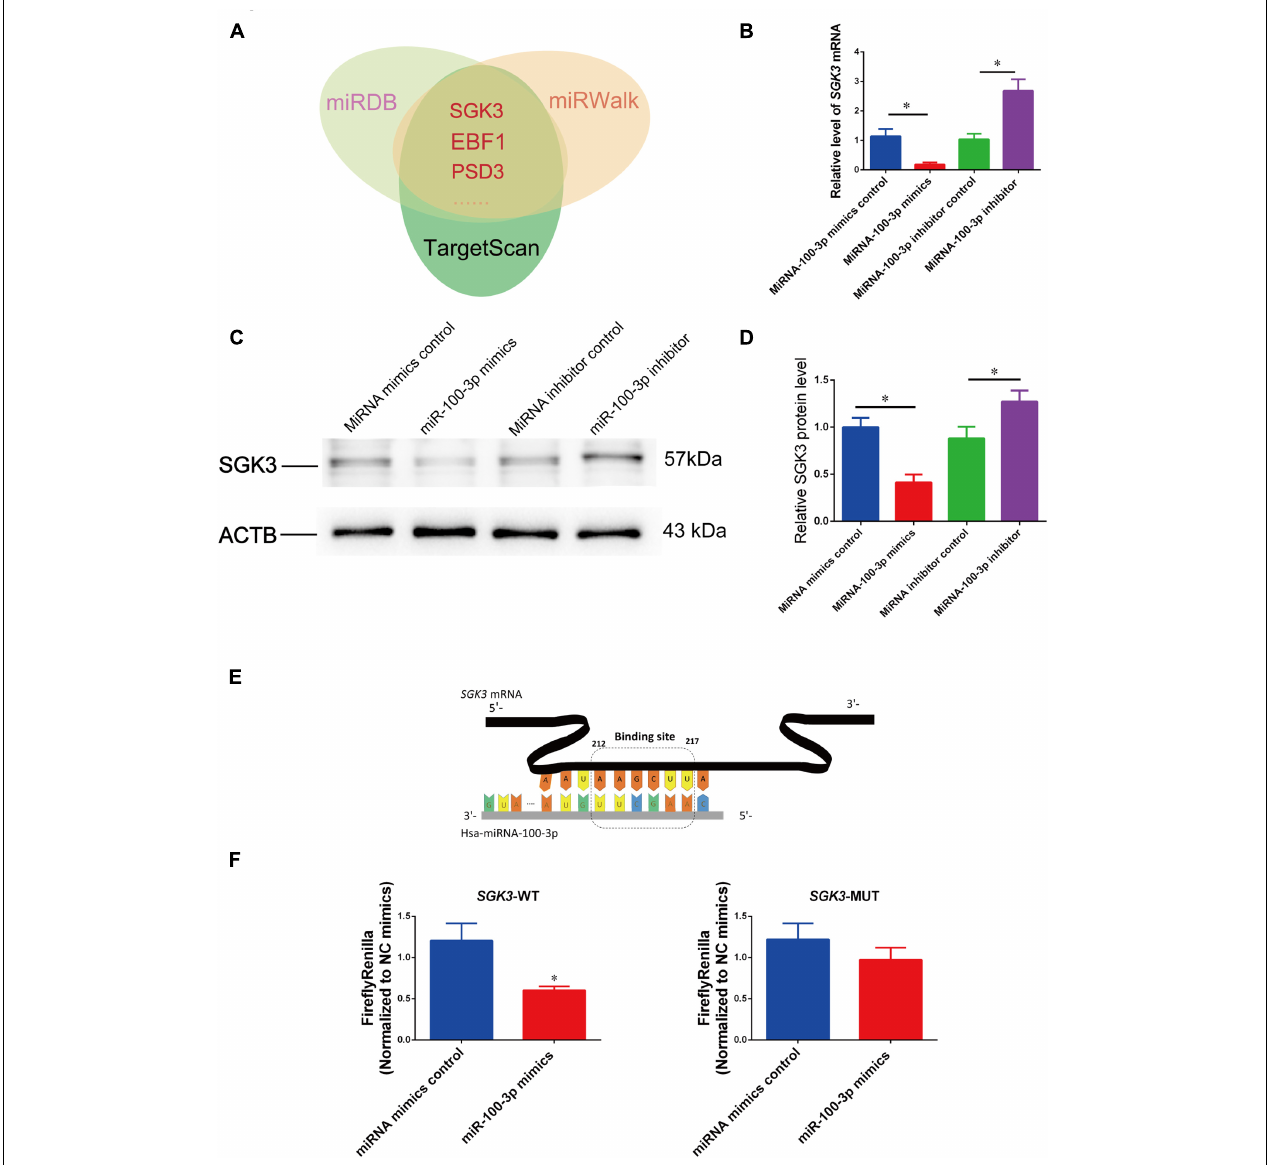
FIGURE 5 | MiR-100-3p binds to serum/glucocorticoid regulated kinase family member 3 (SGK3) in human Sertoli cells. (A) MiR-100-3p targets were predicted by three bioinformatics tools. (B) The relative levels of SGK3 mRNA in human Sertoli cells affected by miR-100-3p mimics or miR-100-3p inhibitor by comparison to the respective control. (C,D ) The relative level of SGK3 in human Sertoli cells at day 3 after transfection of miR-100-3p mimics or miR-100-3p inhibitor after normalization to ACTB (beta-actin). (E) Schematic diagram illustrated the binding site of miR-100-3p to SGK3 mRNA. (F) The binding of miR-100-3p to wild-type SGK3 by dual luciferase assays in human Sertoli cells after transfection of miR-100-3p mimics or the miRNA mimics control. * indicated the statistical difference between miR-100-3p mimics and miRNA mimics control or miR-100-3p inhibitor and miRNA inhibitor